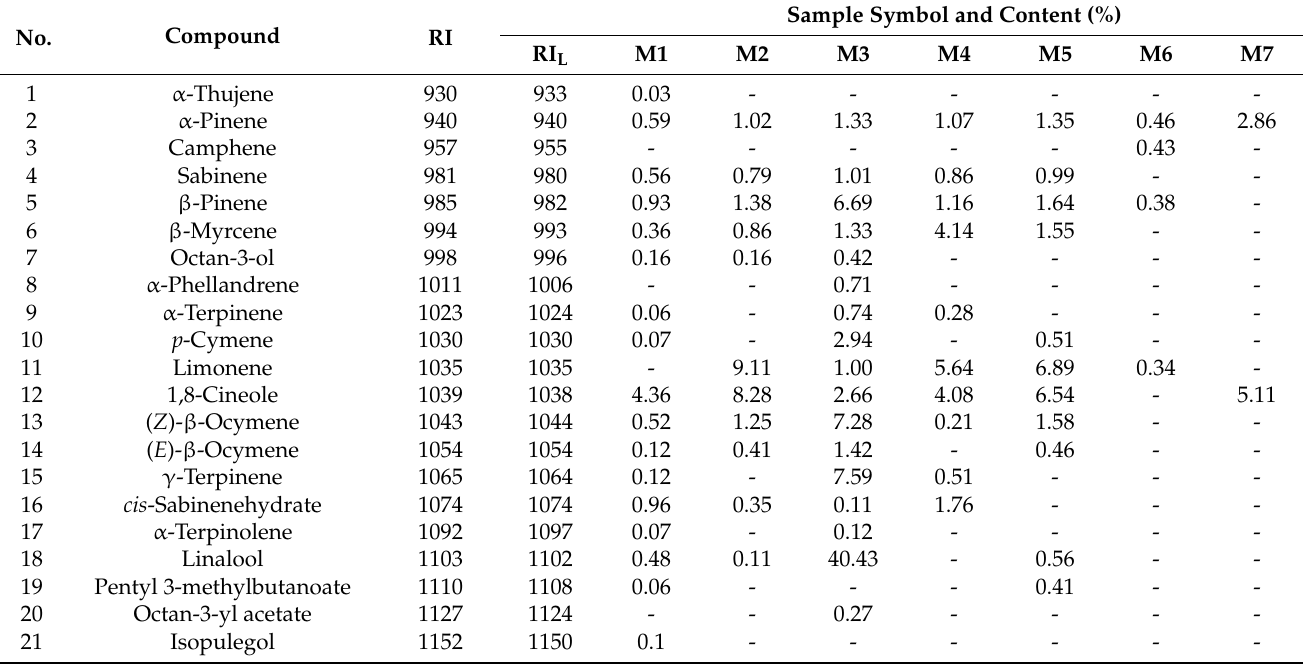
Table 1. Volatile component composition (peak area%) obtained using the HD method and their amount in Mentha spp.